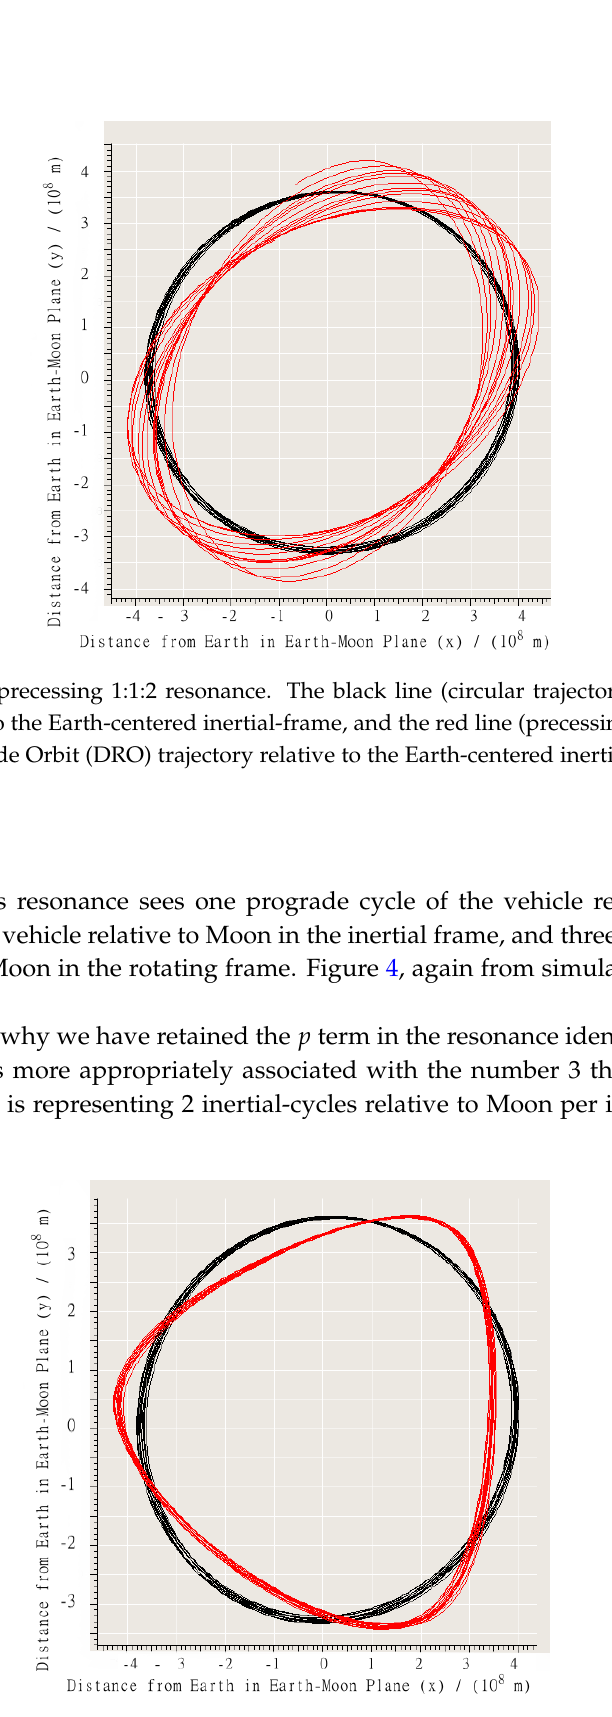
Figure 4. The 1:2:3 Resonance. The black line (circular trajectory) represents the lunar orbit relative to the Earth-centered inertial-frame, and the red line (precessing oval trajectory) the DRO trajectory relative to the Earth-centered inertial frame. Earth is at